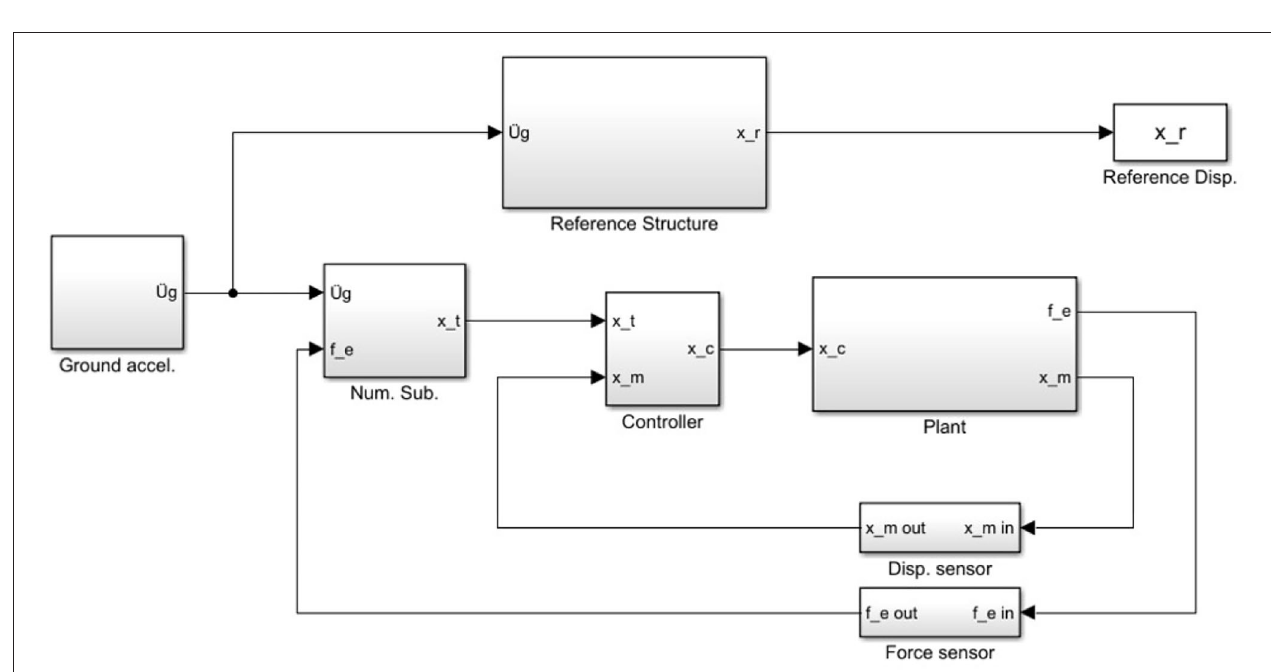
FIGURE 9 | Reference structure and RTHS with